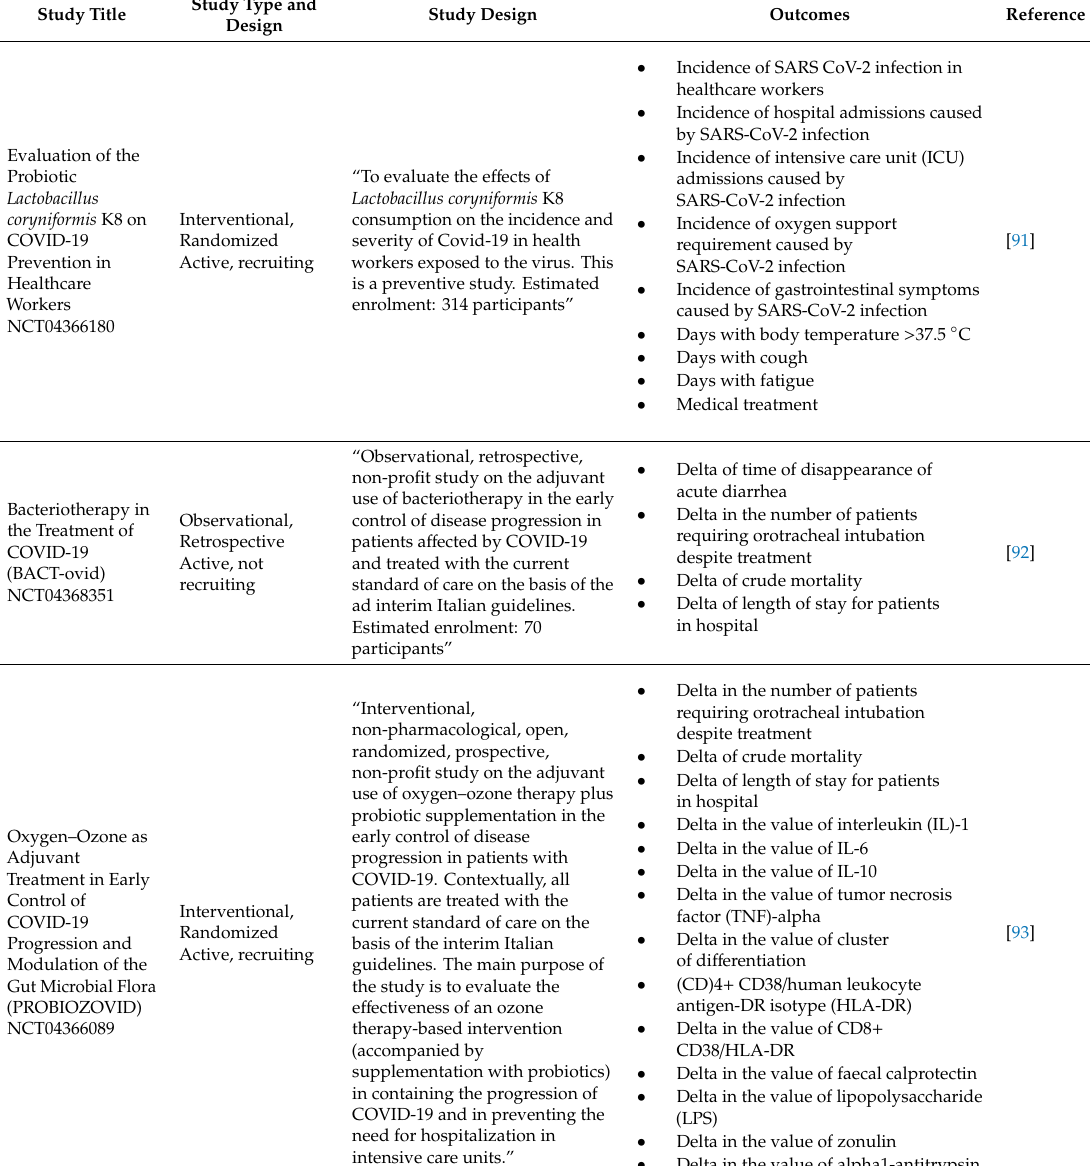
Registered trials evaluating the possible benefits of probiotics administration in COVID-19